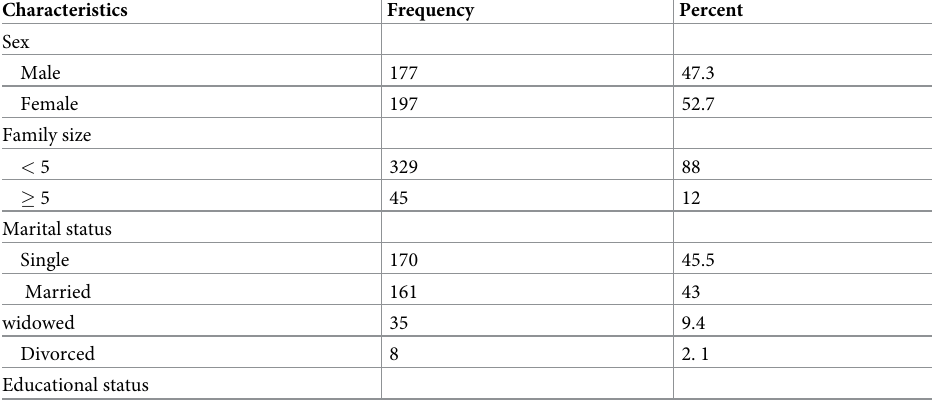
Table 1. Socio-demographic and economic characteristics of study participants in Kombolcha town in April 2020 (n = 374).